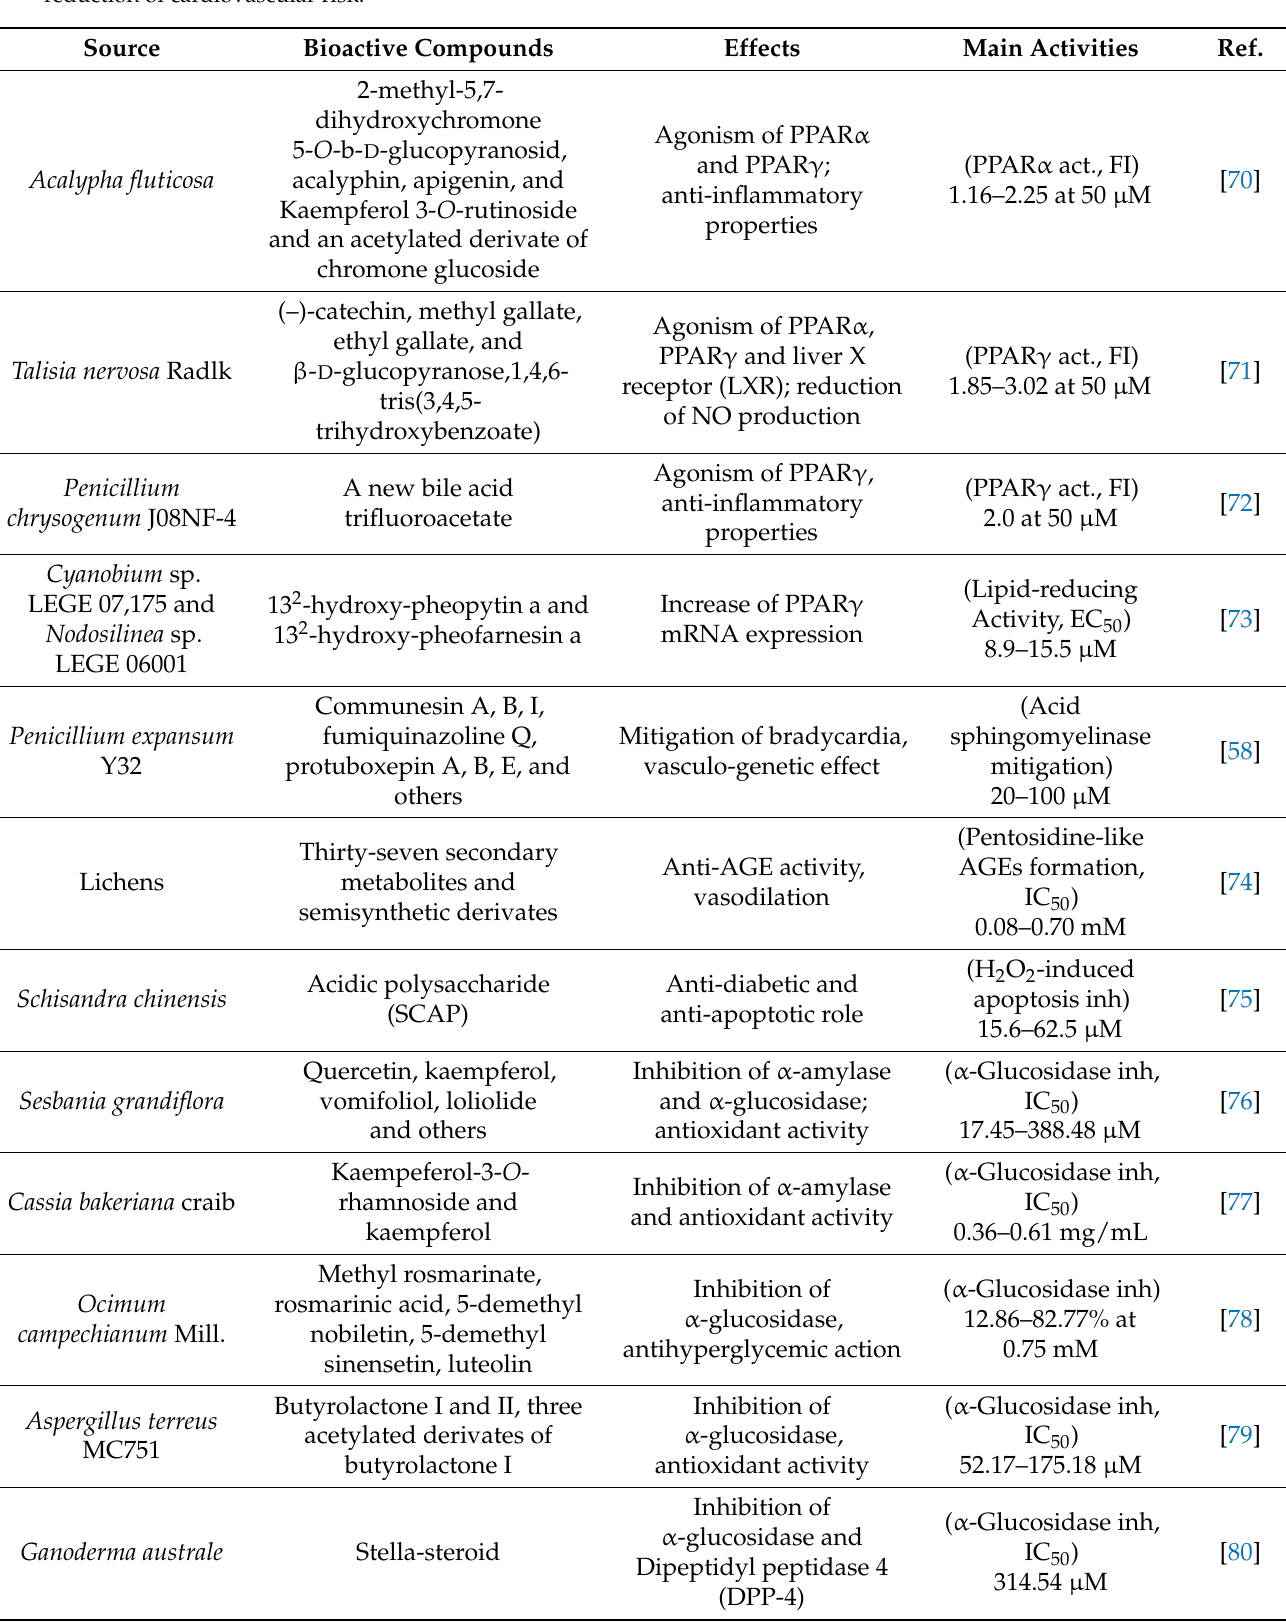
Table 2. Natural compounds with potential use in the therapy of metabolic syndrome and/or with additional effects for the reduction of cardiovascular